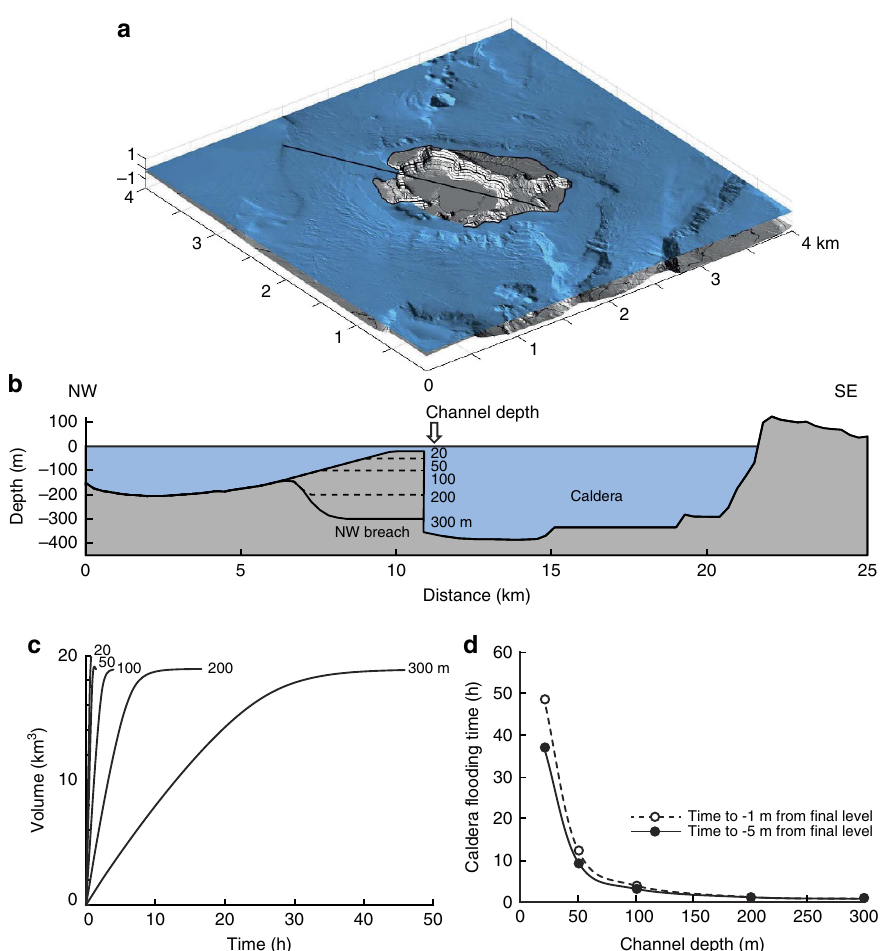
Figure 7 | Numerical modeling of flooding. Model set up and results for the flooding of the caldera resulting from the breach of the NW caldera wall. ( a ) Calculation domain for the numerical modelling, showing the initial (pre-flooding) conditions for the 20m entry model presented in the Supplementary Movie 1. The black line represents the bathymetric profile shown in b . ( b ) Bathymetric profile along the traverse in a , showing the five different starting profiles with caldera-entry depths of 20, 50, 100, 200 and 300m. The bathymetry was kept constant over the duration of each model. ( c ) Intracaldera sea water volume as a function of time for the five models. ( d ) Caldera filling time as a function of caldera-entry depth for final conditions of 5 and 1m below sea